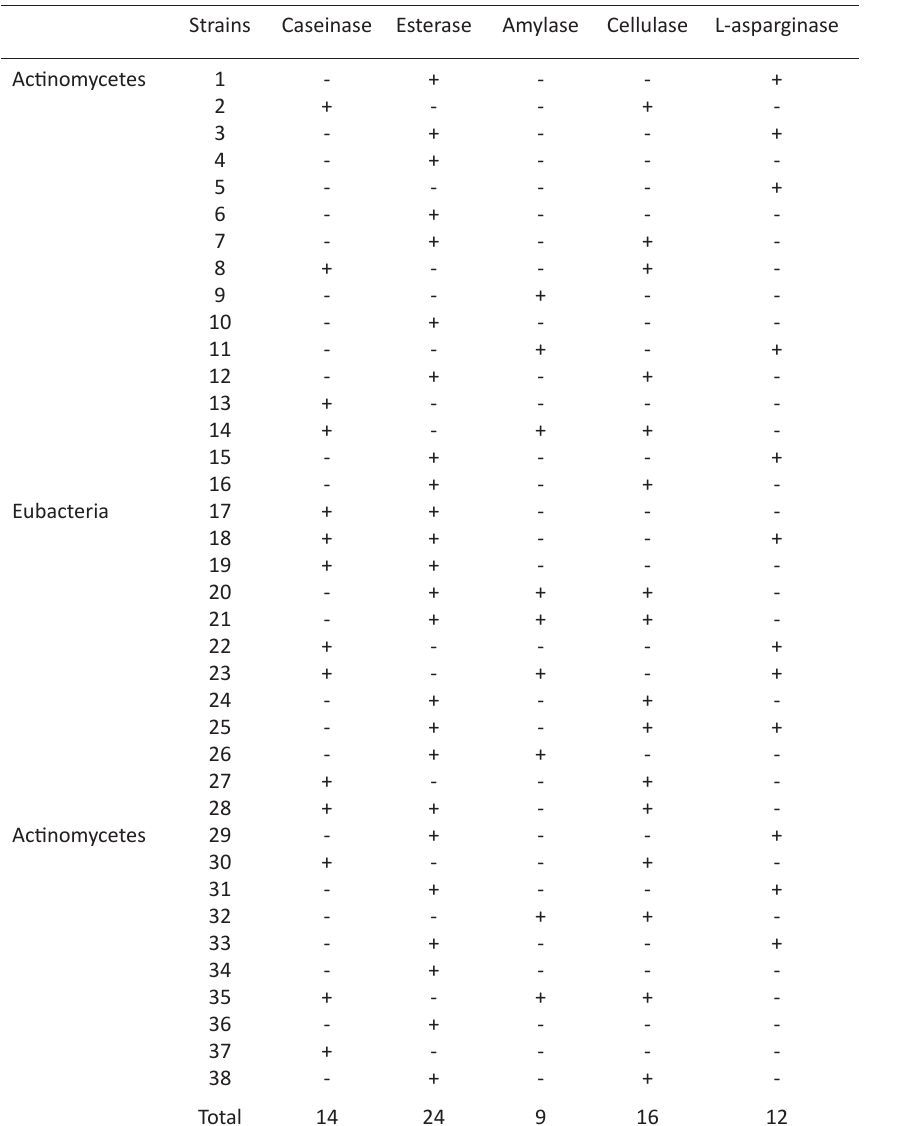
Table 2. Distribution of enzyme producing microorganisms isolated from soil Strains Caseinase Esterase Amylase Cellulase L-asparginase Actinomycetes